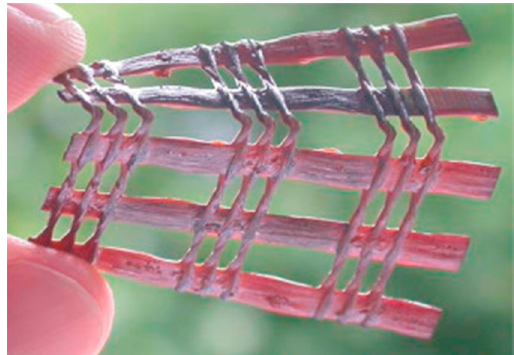
Figure 10. Thin film solar cell on glass fiber fabric developed by Plentz et al. Reprinted from [124] with permission from Elsevier.